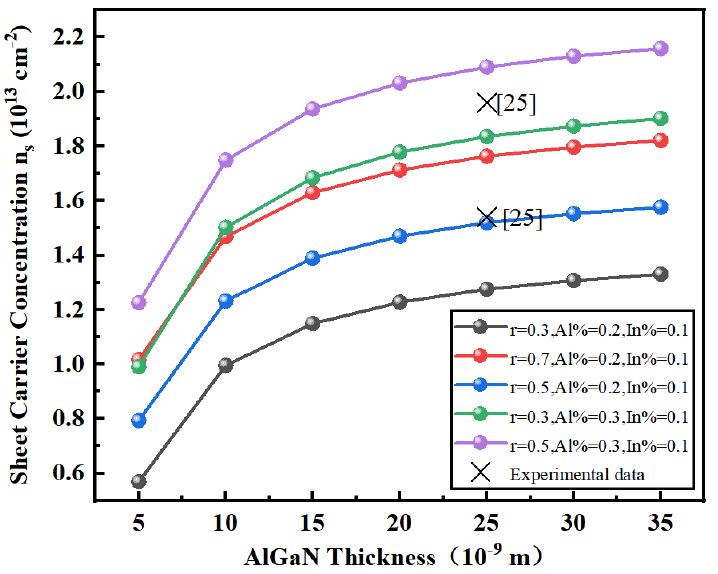
Figure 5. When Al% = 0.25, d In0.1Ga0.9N = 5 nm, and r = 0.5, the AlGaN barrier layer is fully strained, the 2DEG concentration at the AlGaN/InGaN interface n s is at a different d AlGaN .